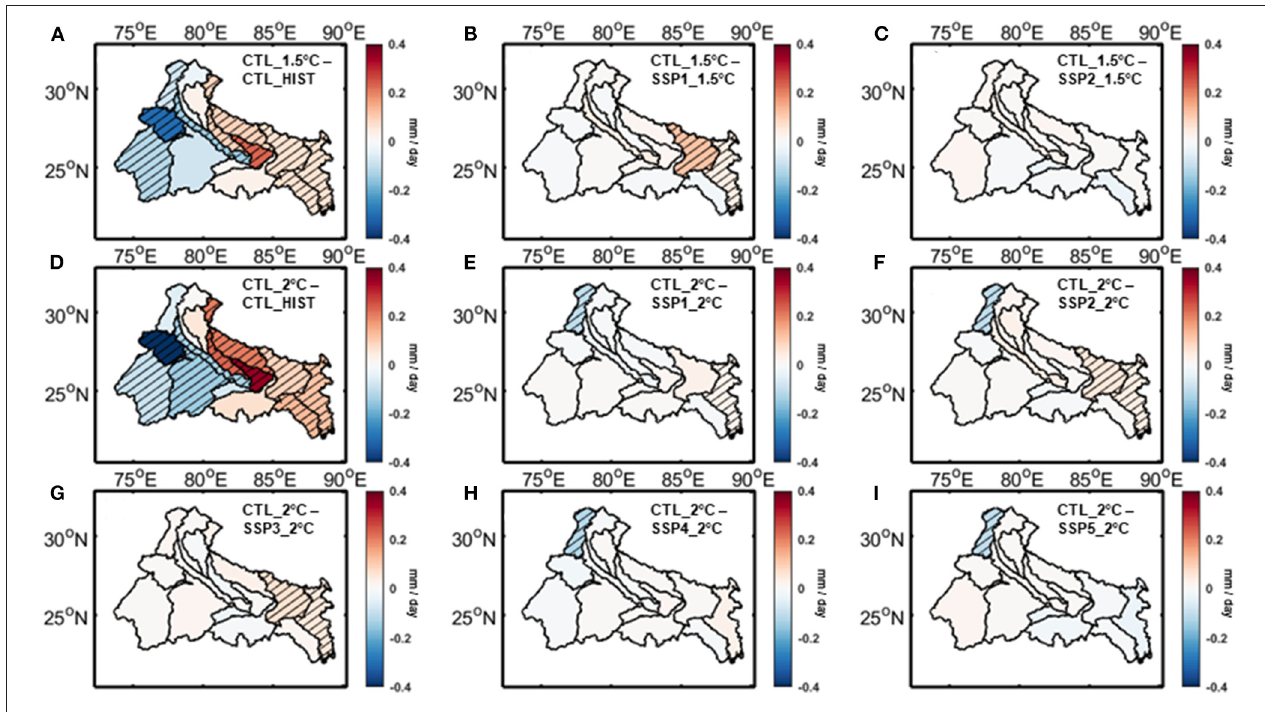
FIGURE 7 | Changes in VIC simulated evapotranspiration associate with climate change for (A) 1.5 ◦ C warming, (D) 2 ◦ C warming and land use change for (B) SSP1_1.5 ◦ C scenario, (C) SSP2_1.5 ◦ C scenario, (E) SSP1_2 ◦ C scenario, (F) SSP2_2 ◦ C scenario, (G) SSP3_2 ◦ C scenario, (H) SSP4_2 ◦ C scenario, (I) SSP5_2 ◦ C scenario over Ganga river basin. Hatched regions denote areas with statistically significant